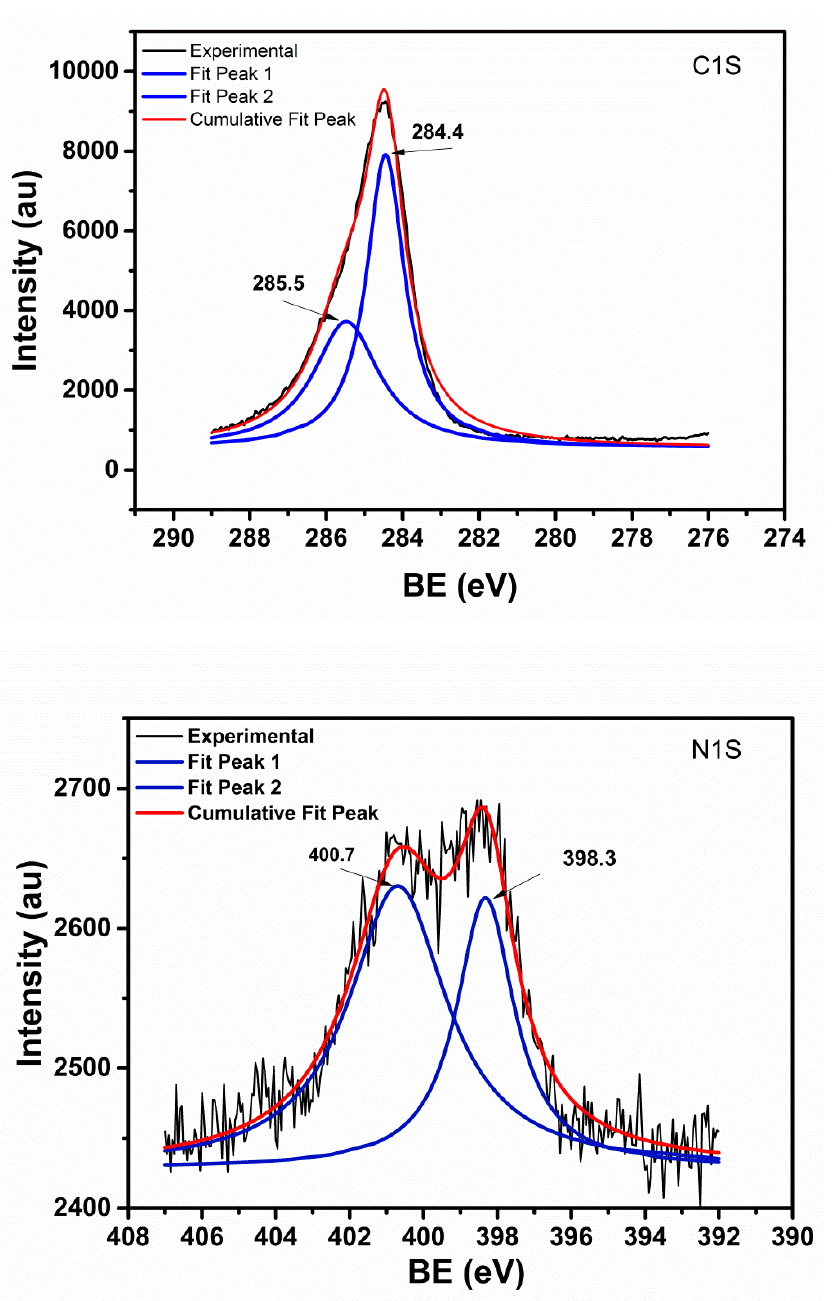
Figure 10. Deconvolution and Lorentzian fit to XPS data for C1s and N1s peaks of sample H2.